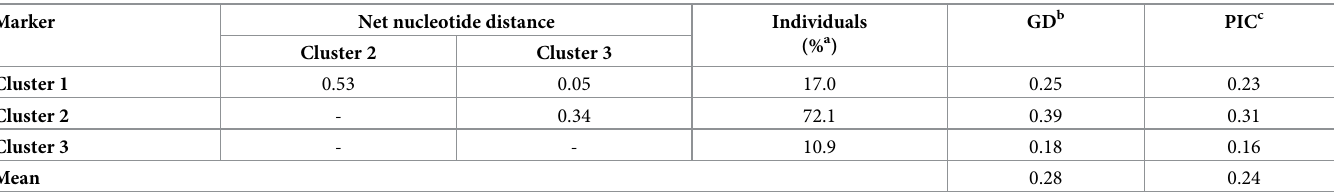
Table 3. Genetic variability among (net nucleotide distance) and proportion of individuals, Major allele frequency, gene diversity, and PIC.